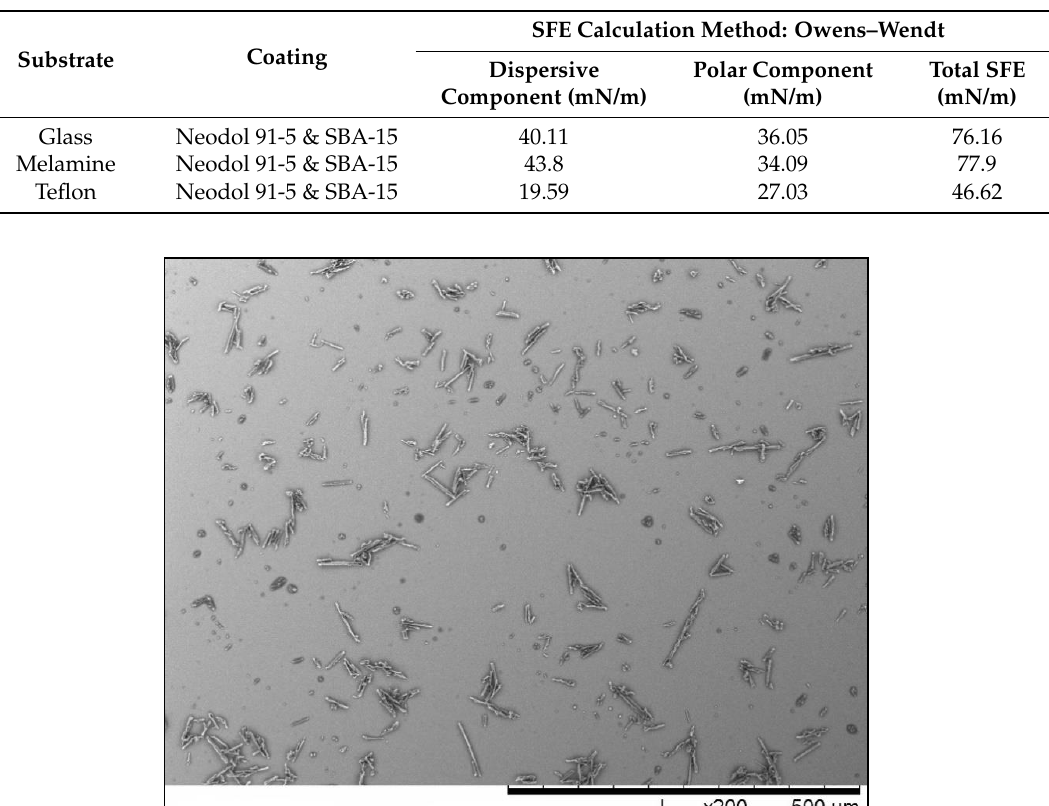
Table 6. Surface Free Energy calculations of the substrates after modification with the Neodol 91-5 & SBA-15 solution.